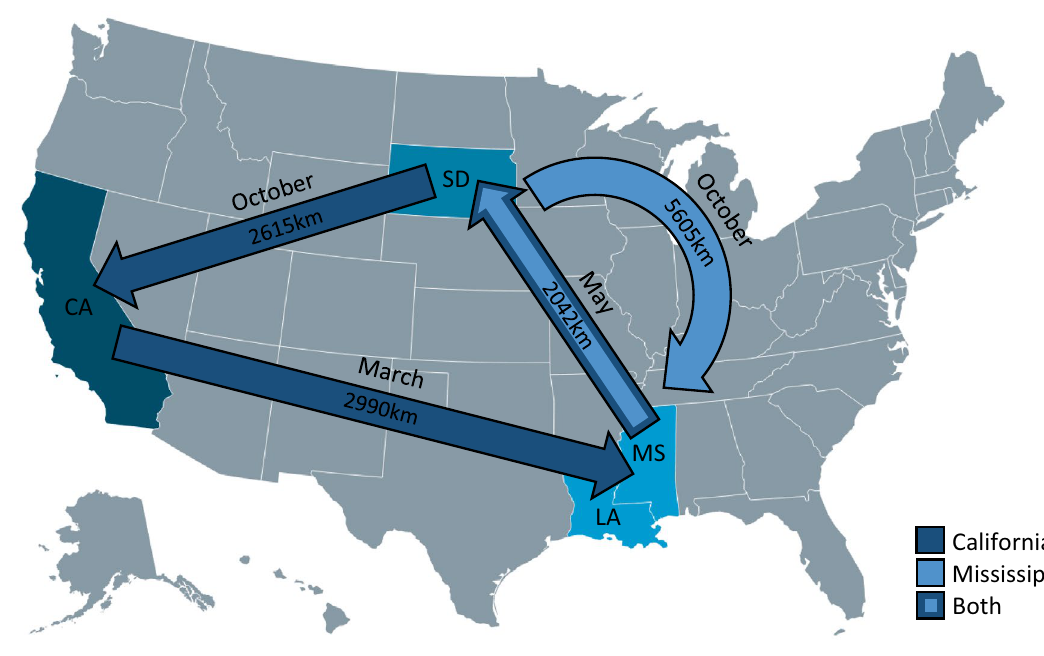
Figure 1. Migration routes used in the experimental setup. Arrows indicate travel routes, distances, and timings for each migration group (California, dark blue; Mississippi, light blue; both, dark and light blue). Choropleth map generated using Datawrapper (release v.